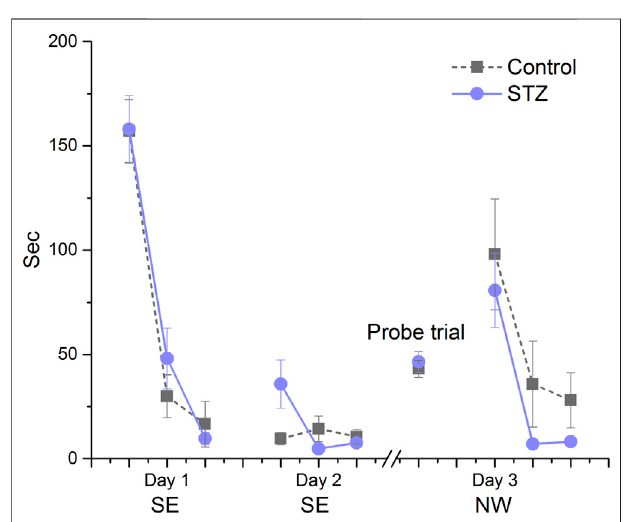
FIGURE 4 | Learning performance in the Morris water-maze in EXP1. Means ± SEM of escape latency values are shown except in the probe trial where the time spent in the target quadrant is depicted. SE and NW indicate the position of the escape platform. There was no signi fi cant difference between groups in the acquisition trialson days 1 and 2 (group effect: F (1,15) (cid:2) 0.89, ns; Day × trial × treatment interaction: F (2,30) (cid:2) 1.94, ns),inthe probetrial (unpaired t -test: t (15) (cid:2) − 0.51, ns) and during re-acqusition on Day 3 (group effect: F (1,15) (cid:2) 1.60, ns, Day × treatment interaction: F (2,30) (cid:2) 0.11,